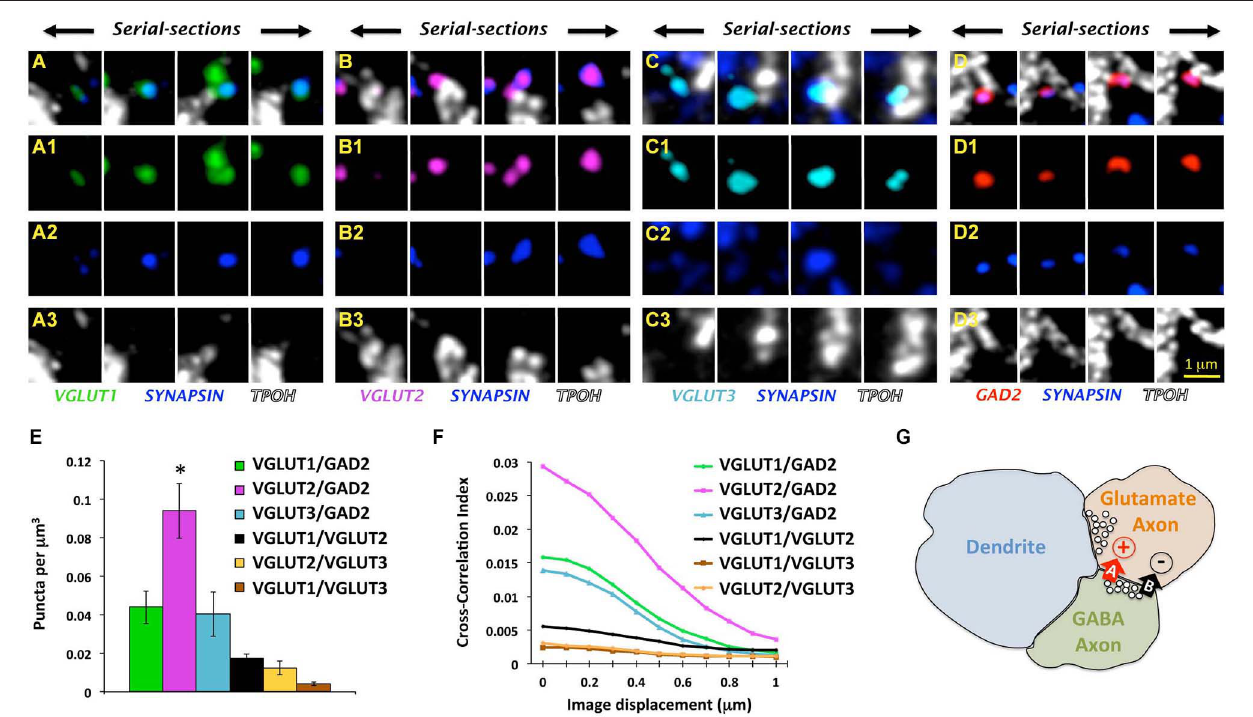
degree of colocalization of VGLUT2 axon terminals with GAD2 boutons in comparison to other glutamate axons. Specifically, when imaging channels were aligned ( x = at 0 µ m of displacement), the pixels co-labeled for VGLUT1-3 and synapsin showed the highest value of correlation with pixels co-labeled for GAD2 and synapsin. When imaging channels were displaced with respect to each other all of the correlation values decreased indicating the spatial proximity of all three glutamate axon types with GABA boutons (Soiza-Reilly et al., 2013). Cross-correlations between different glutamate axon types were very low. (G) Schematic illustration of the GABAergic presynaptic modulation of glutamate release in the synaptic triads of the DRN. Adjacent glutamate and GABA axon terminals are closely associated with a postsynaptic dendrite that receives a typical excitatory asymmetric synapse from the glutamatergic bouton. GABA boutons would have the capacity of presynaptically influencing glutamate release from terminals through a dual mechanism involving a rapid/transient GABA-A receptor-mediated facilitation, and a more delayed and sustained GABA-B receptor